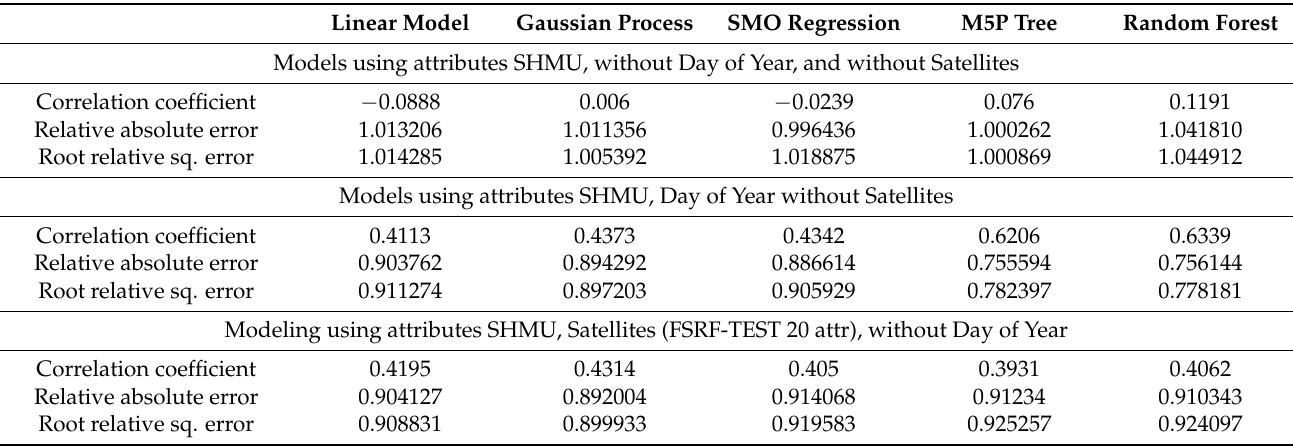
Table 4. Overview of trained regression models and their accuracy metrics for the field-measured values of target variable g02 (electrical